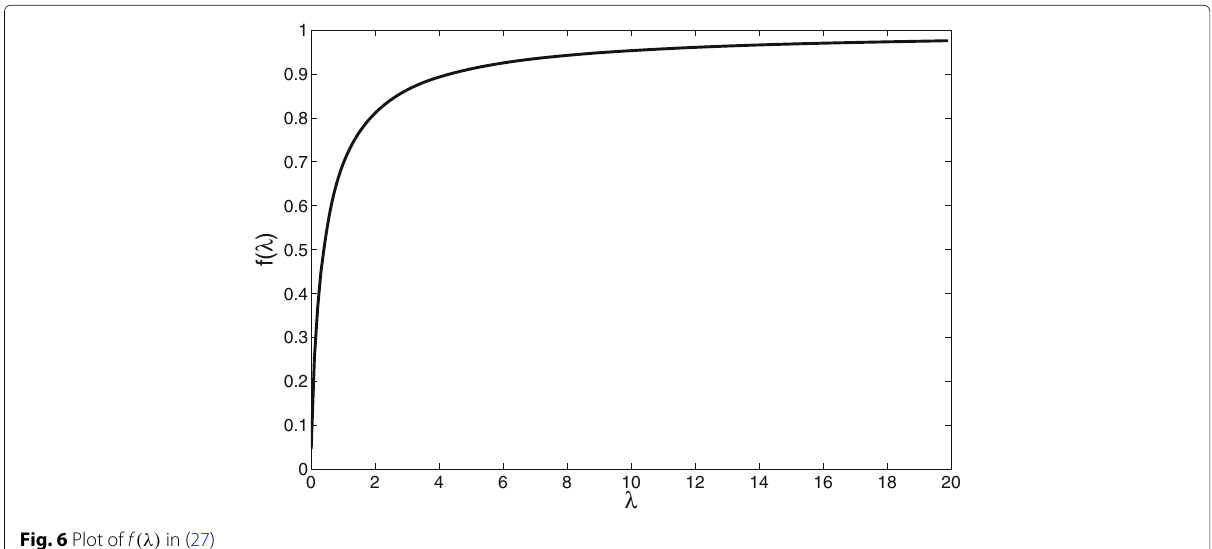
Fig. 6 Plot of f (λ) in